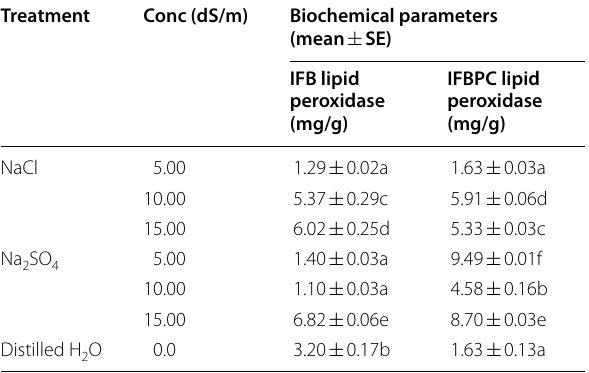
Table 4 Superoxide dismutase (SOD) activities in the leaves of Ife brown (IFB) and Ife bpc (IBPC) under NaCl and Na SO salinity 2 4 stress